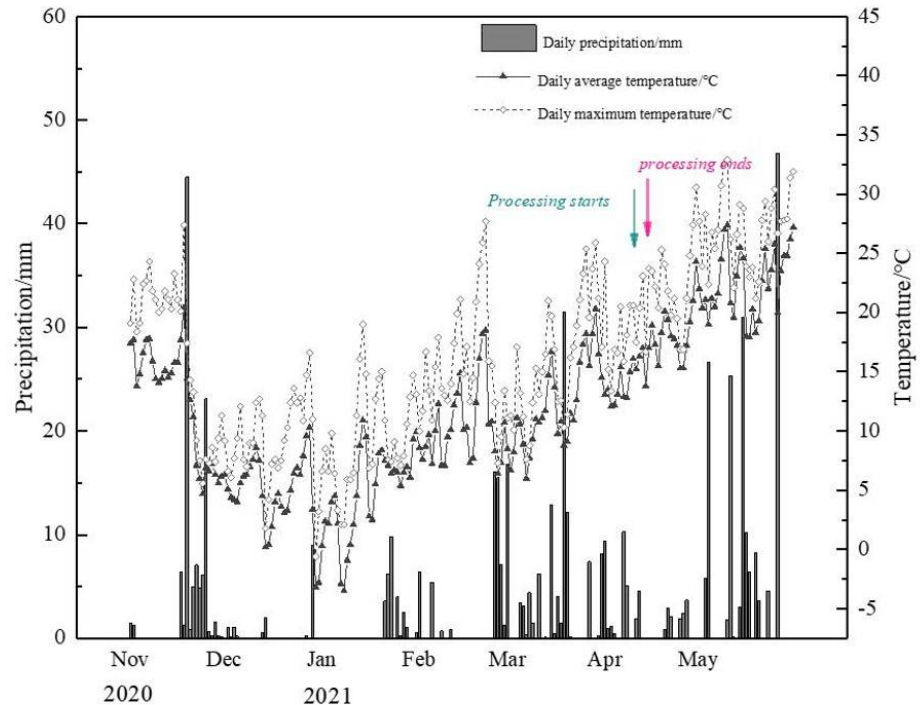
Figure 2. Daily precipitation and temperature during the wheat growing season.